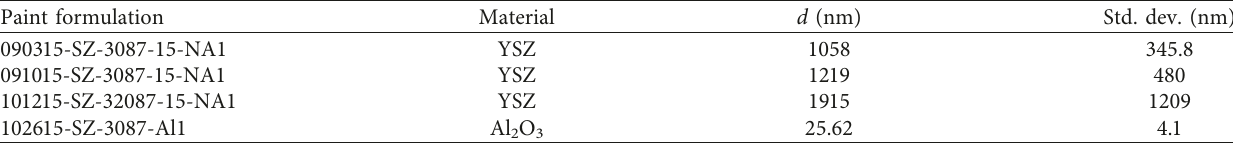
Table 1: The average particle size found for several formulation paints from DLS. Paint